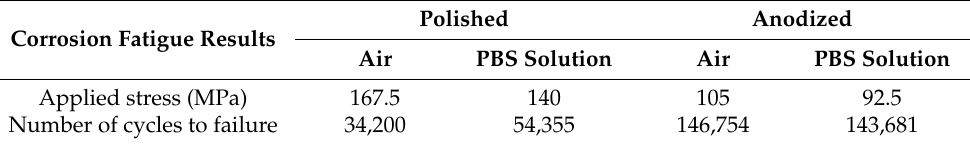
Table 5. Specimens chosen for fracture analysis after the corrosion fatigue